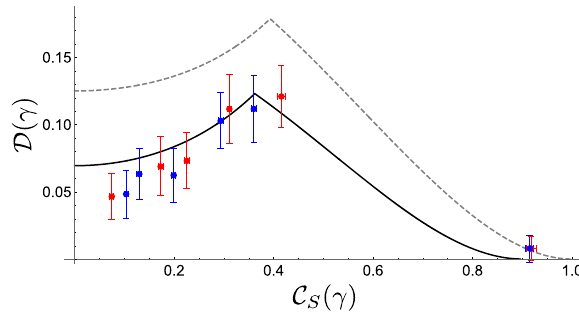
Fig. 6 Geometric discord D for the post-selected bipartite output state as a function of the local coherence C S ( S = A , B ). The dashed gray upper curve is the theoretical prediction from (14). The red and blue points correspond to experimental points obtained by considering the local marginals of A or B , respectively. The black curve is a the theoretical model taking into account dephasing and polarization mode mismatch. The experimental error bars were obtained by Monte Carlo simulation of 500 runs obeying the same Poissonian count